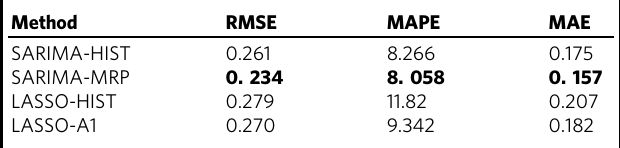
The rows indicate a model loss — root mean squared error (RMSE), mean average percent error (MAPE), and mean average error (MAE). See Supplementary Information 6.8 for loss calculations. Bold text indicates minimum